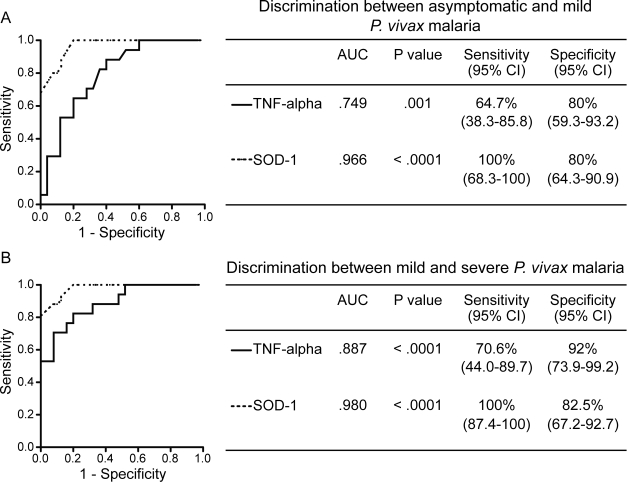
Effectiveness of plasma concentrations of SOD-1 and TNF-alpha measurements as markers of vivax malaria severity.A, ROC curves of SOD-1 (dashed line) and TNF-alpha (solid line) plasma levels for discriminating asymptomatic infection from mild P. vivax malaria cases. B, ROC curves of SOD-1 (dashed line) and TNF-alpha levels (solid line) for discriminating severe from mild P. vivax malaria cases. C-statistics are illustrated in the tables and were used to verify the validation of the ROC curves and the predictive power of each biomarker. AUC, area under the curves; CI, confidence interval.